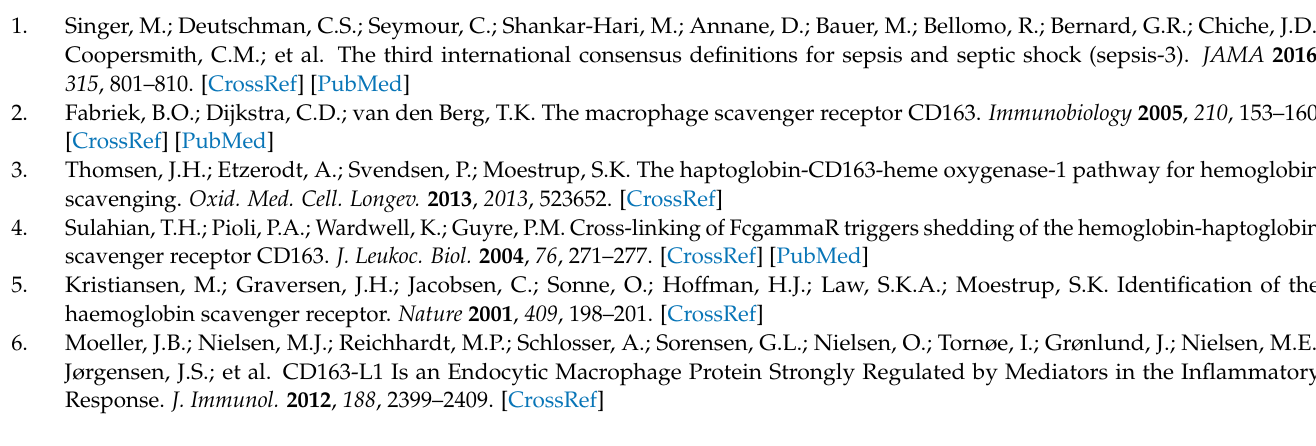
MODEL 1 (Table 6: Model